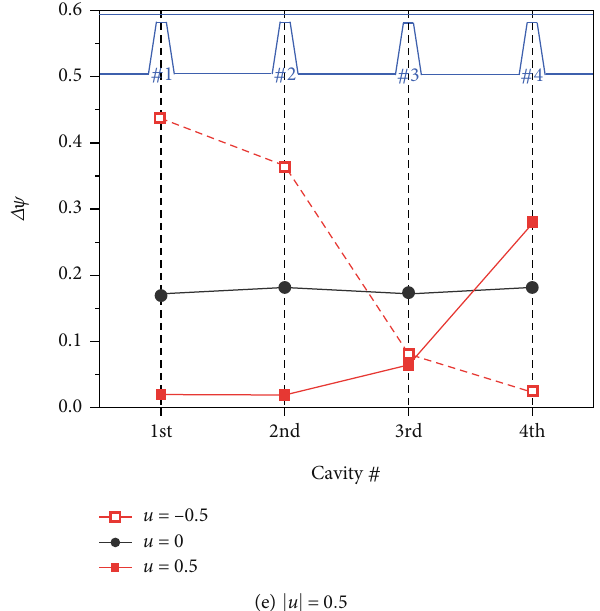
= 0 : 23 , and C = 0 : 067 ). U